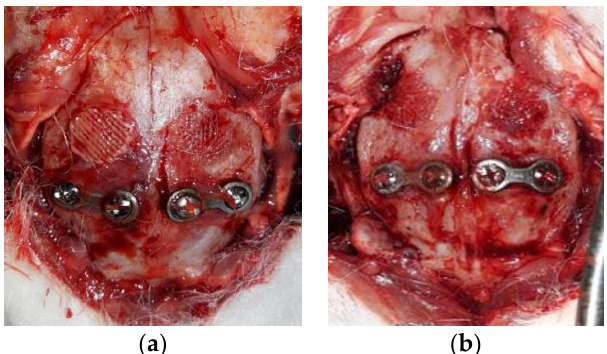
Figure 11. Four weeks after the initial operation, the untreated two-hole straight plate ( a ) and two-hole straight plate treated with amine plasma ( b ) were dissected. The periosteum and surrounding tissue remained around the untreated two-hole straight plate. In contrast, a relatively clear separation of tissue around the two-hole straight plate treated with plasma can be observed.